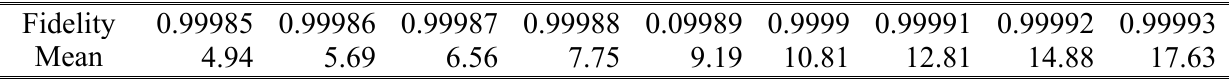
Table 3. Mean subspace dimensions for different fidelity